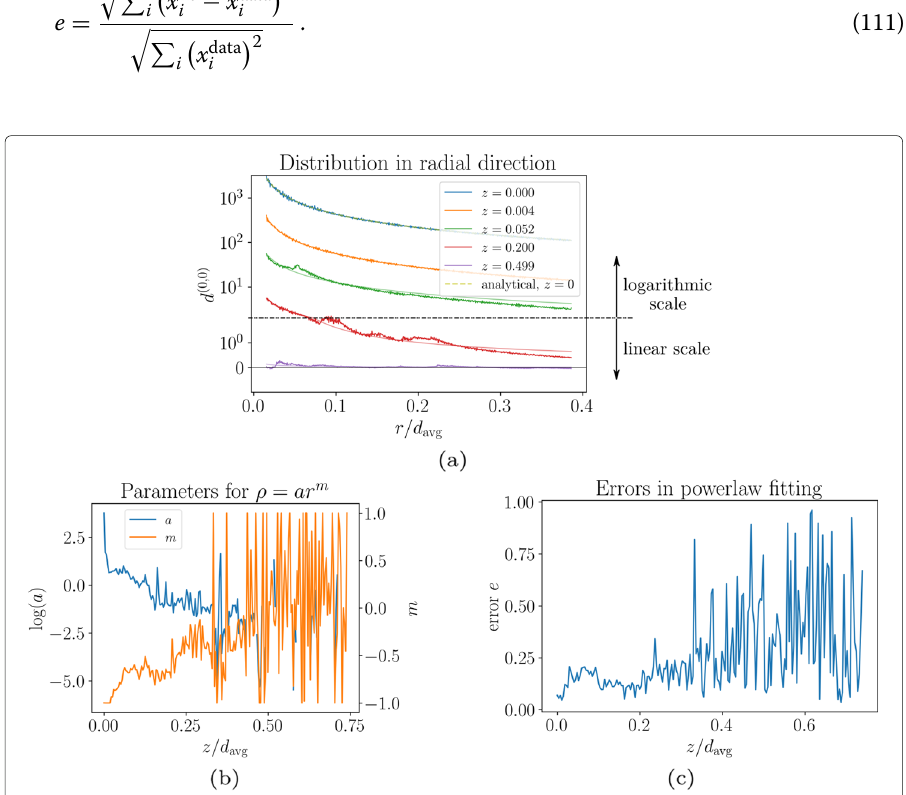
Fig. 17 Analysis of the r -dependency of the correlation. The data is averaged over the angular domain. r -dependent correlation for various values of z ( a ). The ordinate uses a logarithmic scale which transitions into a linear scale for values smaller than 2. Coefficients of the power law fitting dependent on the normal distance z ( b ). Error in the power law fitting according to Eq. (111) ( c